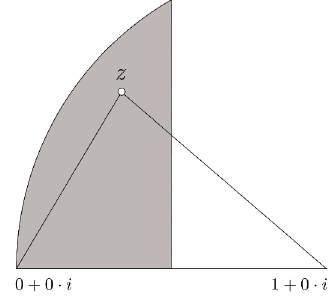
Figure 2. The normalized region Σ = { 0 < Re( z ) ≤ 1 / 2 , Im( z ) > 0 ,|z − 1 | ≤ 1 } .